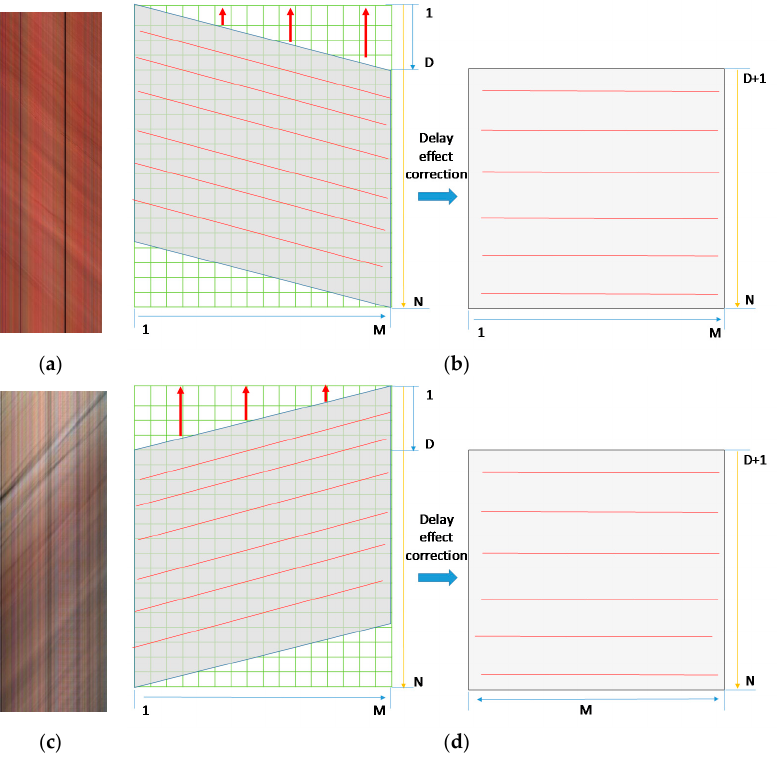
Figure 14. 90 ◦ yaw images and delay lines in different columns, including the ( a ) subset image and ( b ) delay effect correction scheme for SPARK-01 satellite images and the ( c ) subset image and ( d ) delay effect correction scheme for SPARK-02 satellite